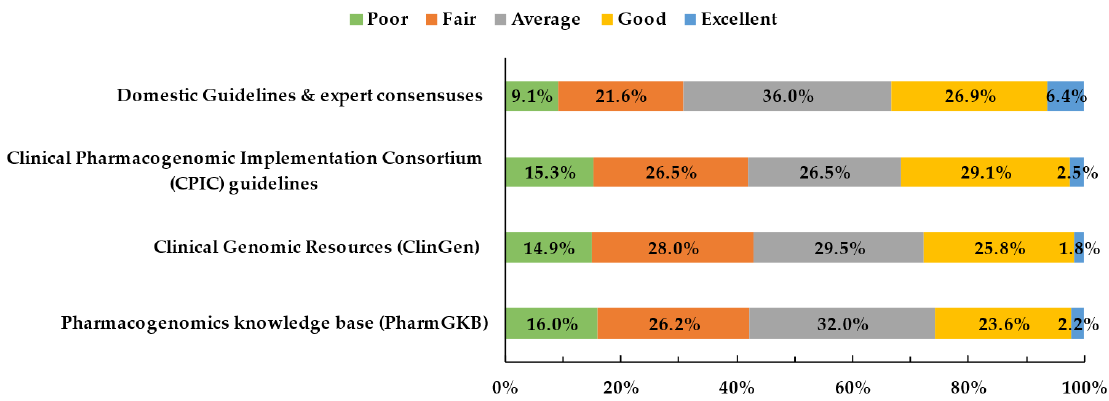
Figure 1. Physicians’ knowledge of resources related to PGx testing.